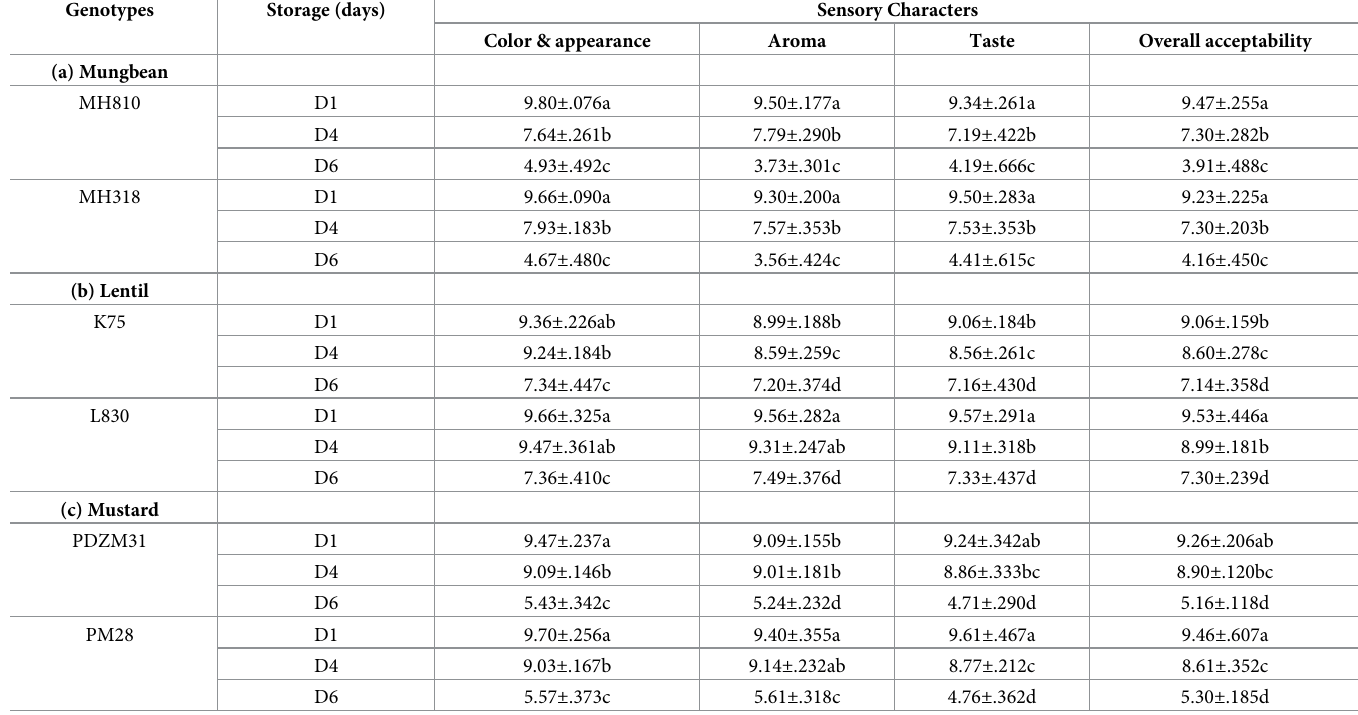
Table 5. Sensory details including color & appearance, aroma, taste and overall acceptability of (a) mungbean (MH810 & MH318), (b) lentil (L830 & K75), and (c) Indian mustard (PM28 & PDZM31) microgreens.